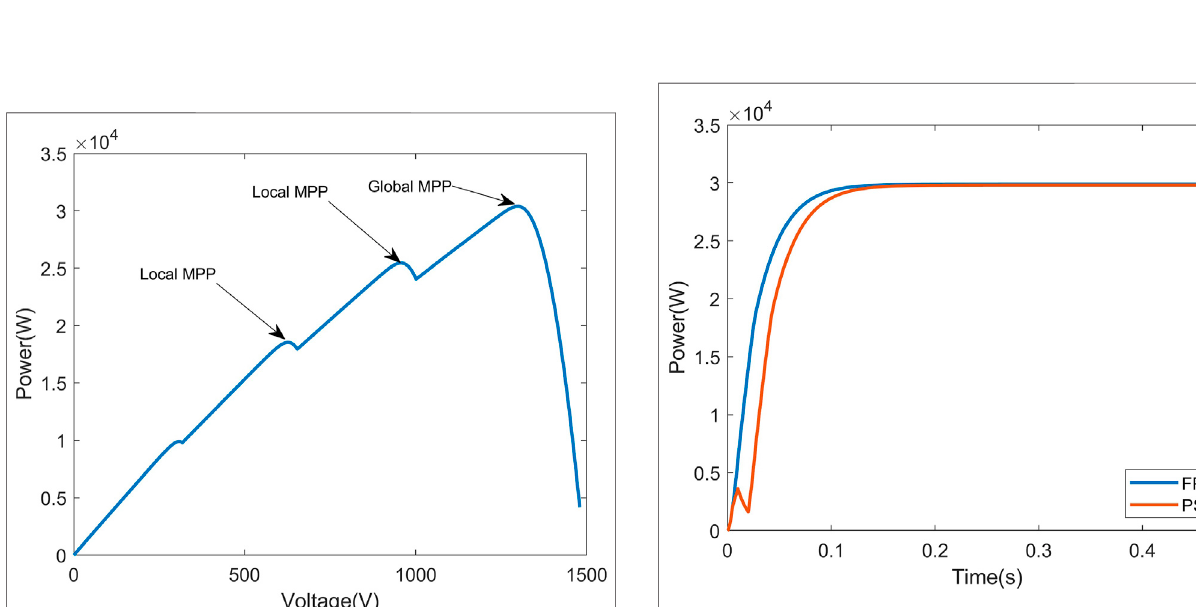
FIGURE 7 | PV curve for irridiation 1.